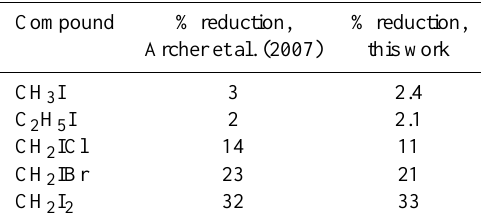
Table 6. Comparison of the reduction in calculated total transfer ve- locity ( K w ) for a series of iodocarbons from the dataset of Archer et al. (2007) when considering both k w and k a , relative to the trans- fer velocity calculated using k w